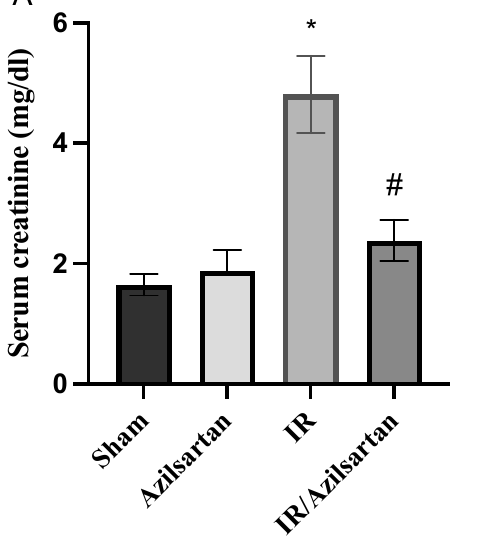
Figure 1. Creatinine ( A ) and BUN ( B ) serum levels. Bars represent mean ± SD. Followed by post hoc Dunnett test, significant difference was analyzed by one-way ANOVA test, where * p < 0.001, compared to the sham group, and # p < 0.001, compared to the IR group. BUN; blood urea nitrogen, SD; standard deviation, IR; ischemia reperfusion.